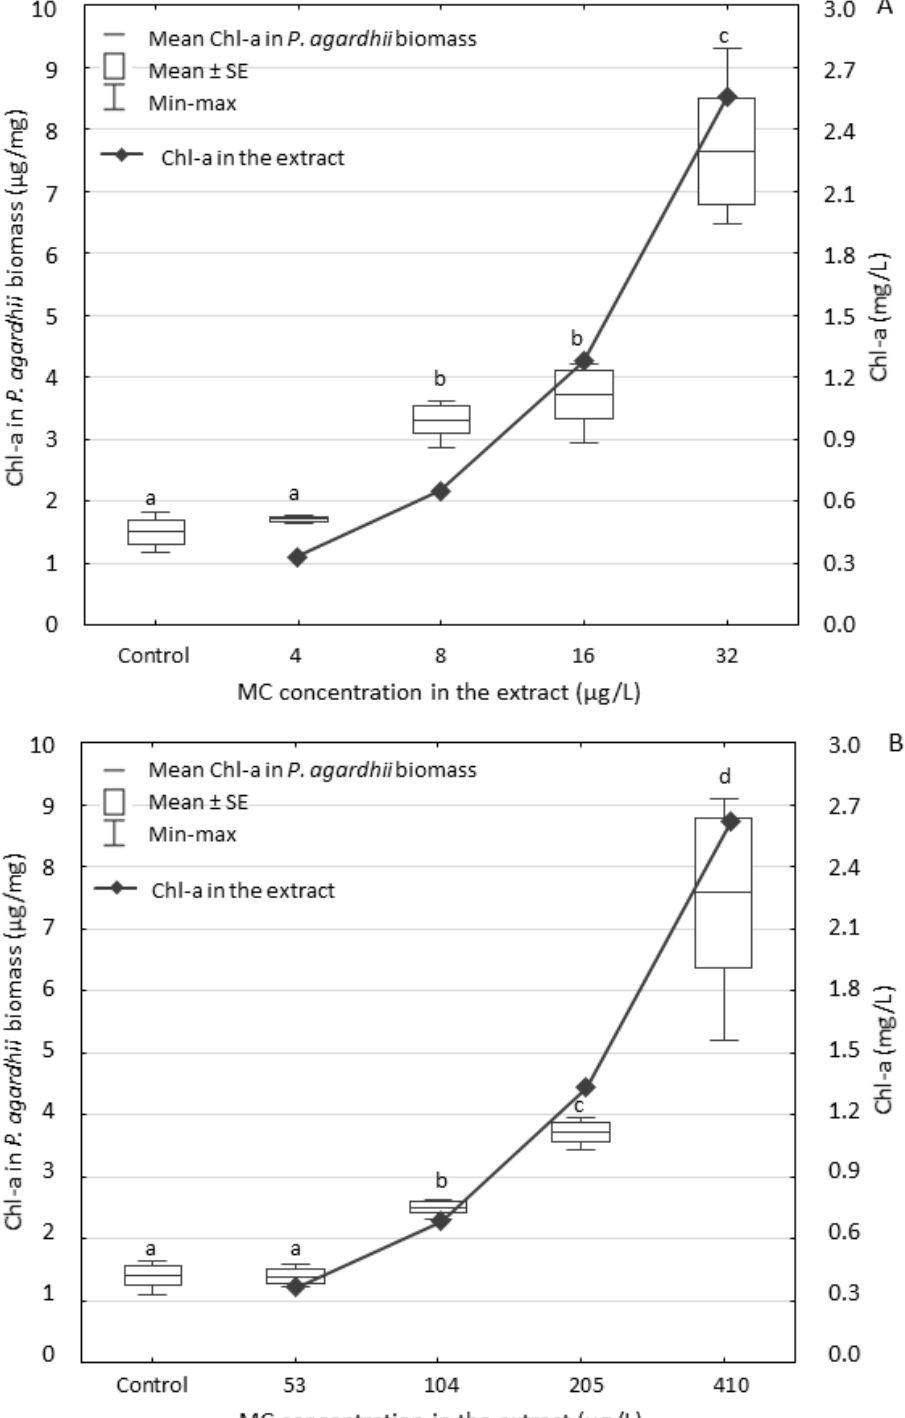
Figure 3. Chl-a content in P. agardhii biomass after the seven-day exposure to the extracts Pa-A ( A ) and Pa-B ( B ) originally containing di ff erent concentrations of MCs. Both extracts dilutions had similar concentration of Chl-a. Data are expressed as means ± SE, n = 3. Di ff erent lowercase letters (a–d) indicate statistically significant di ff erences between experimental treatments (ANOVA, Tukey’s test, p < 0.05).